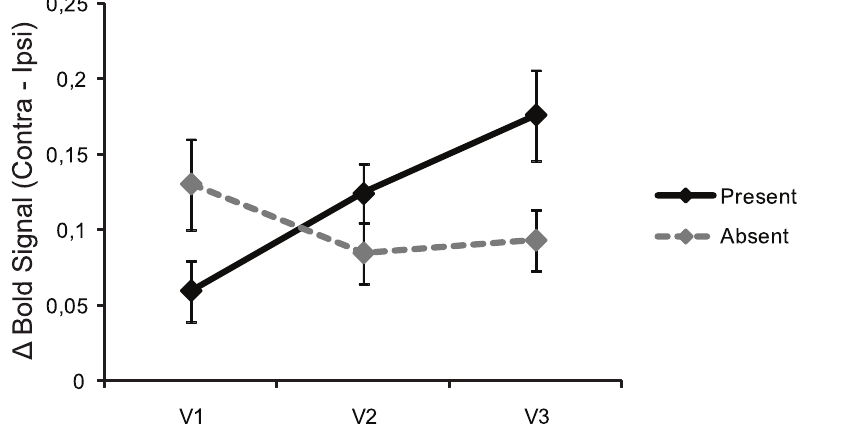
Figure 4. Effects of attention (contralateral – ipsilateral BOLD responses) for distractor present and absent trials. The data points reflect averaged BOLD responses over the two hemispheres for TR=4, reflecting the peak of the BOLD signal. When distractors were expected, the effect of attention differs in the early visual areas, increasing linearly over higher visual areas (black line). This effect was not observed when distractors were not expected (gray line). Error-bars reflect standard-error corrected for the use of a within-subjects